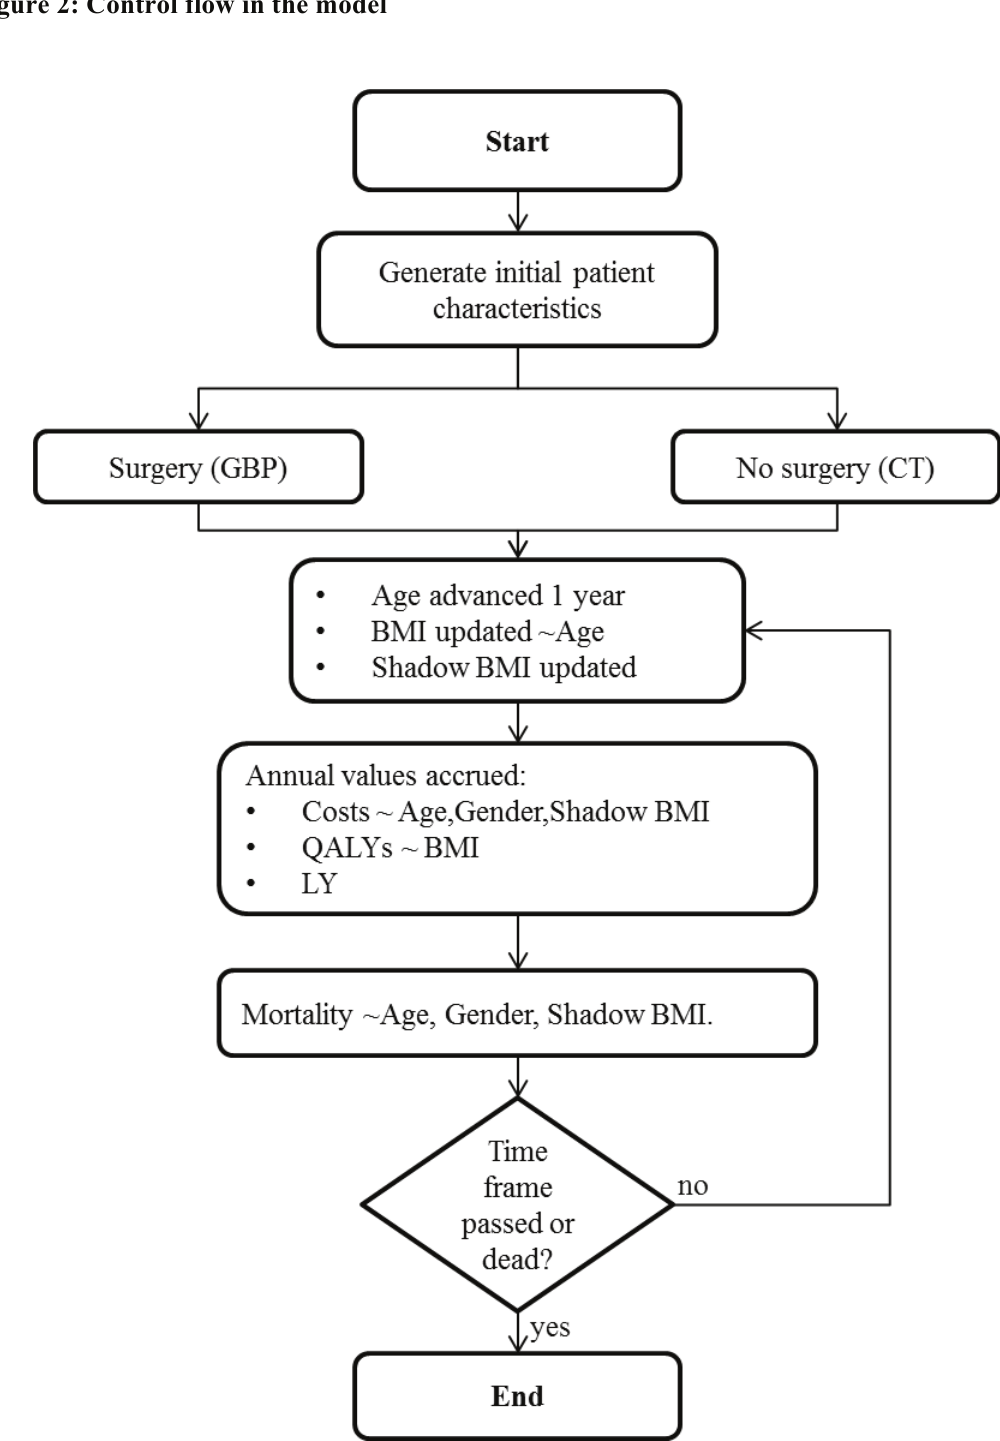
Figure 2: Control flow in the